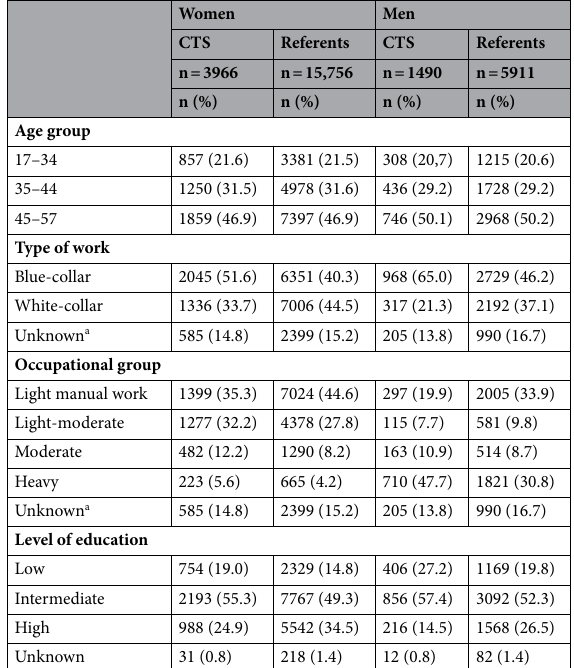
Table 1. Characteristics in the carpal tunnel syndrome (CTS) cohort and the matched reference cohort without CTS. a Includes true missing as well as unemployed, students, disability pension, early retirements, entrepreneurs and project